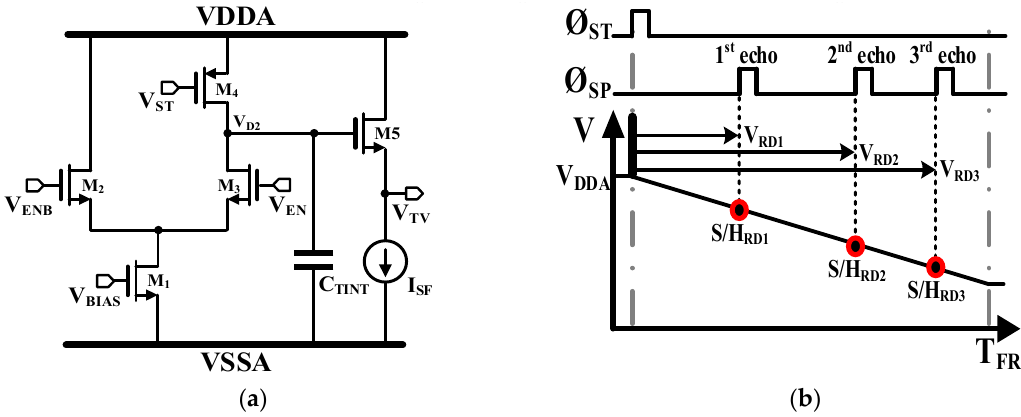
Figure 8. ( a ) Simplified schematic of a TVC and ( b ) its operation.